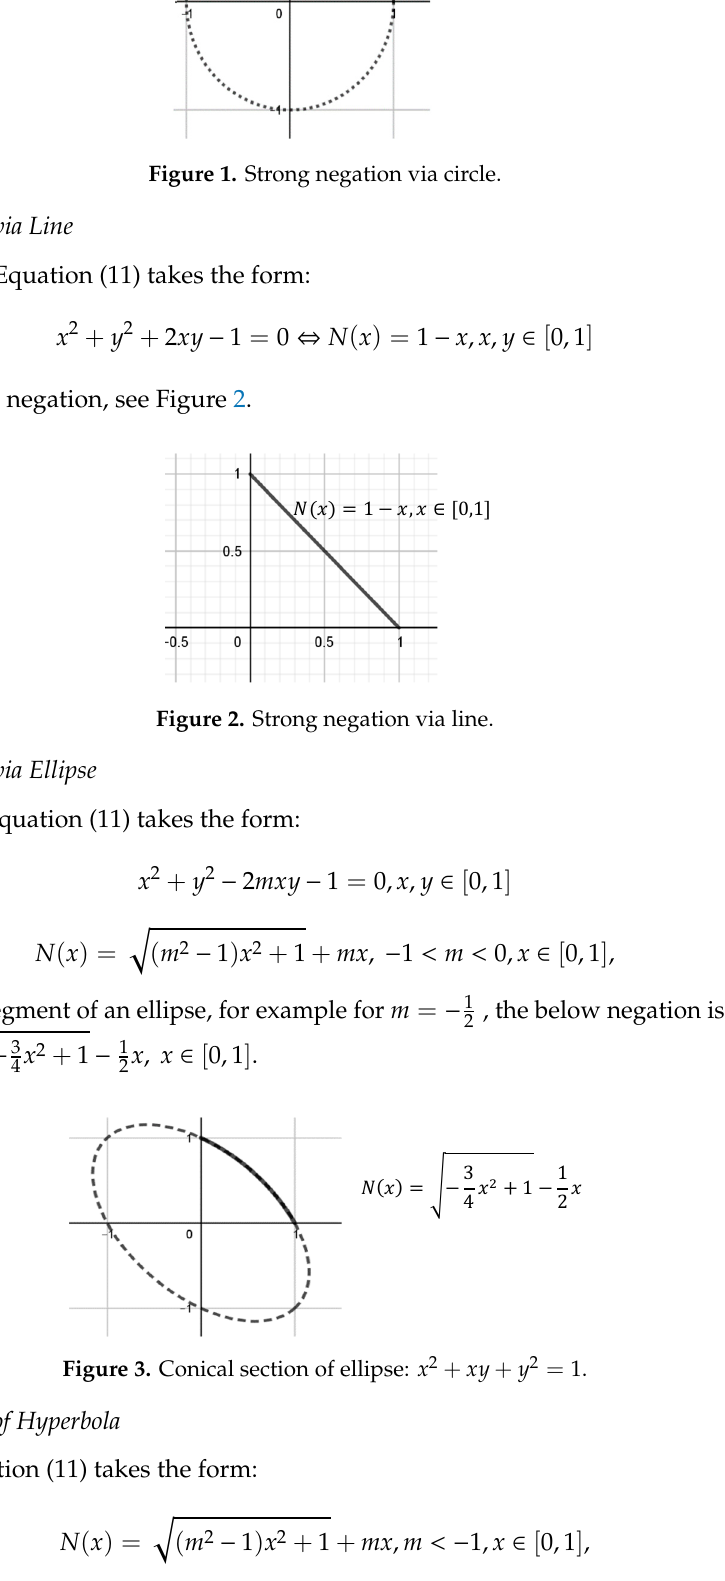
Figure 4. Conical section of hyperbola: